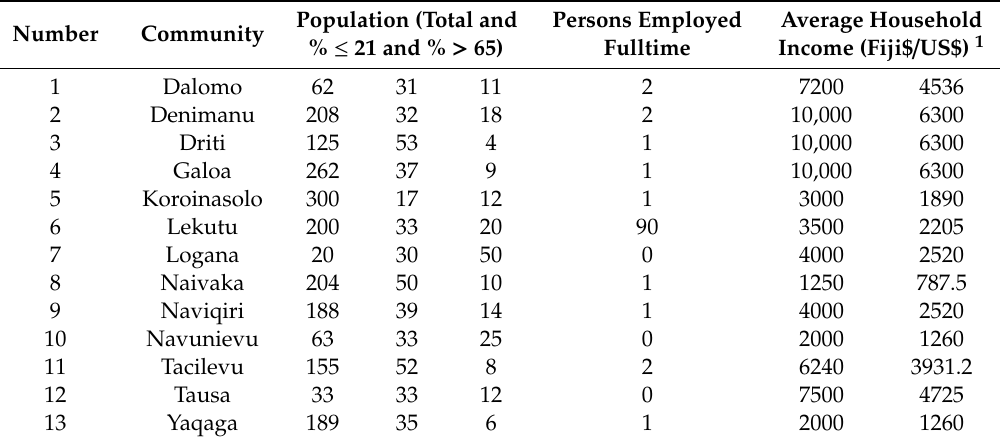
Table A1. Population and employment data for Bua communities.